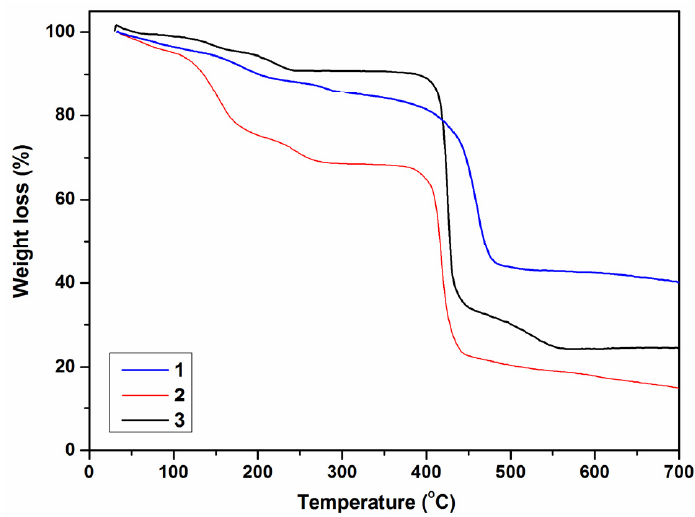
Figure 4. The TGA curves of frameworks 1 , 2, and 3 .